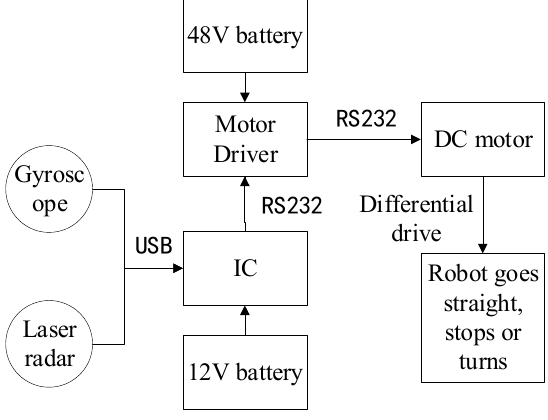
Figure 2. The principle of the system.